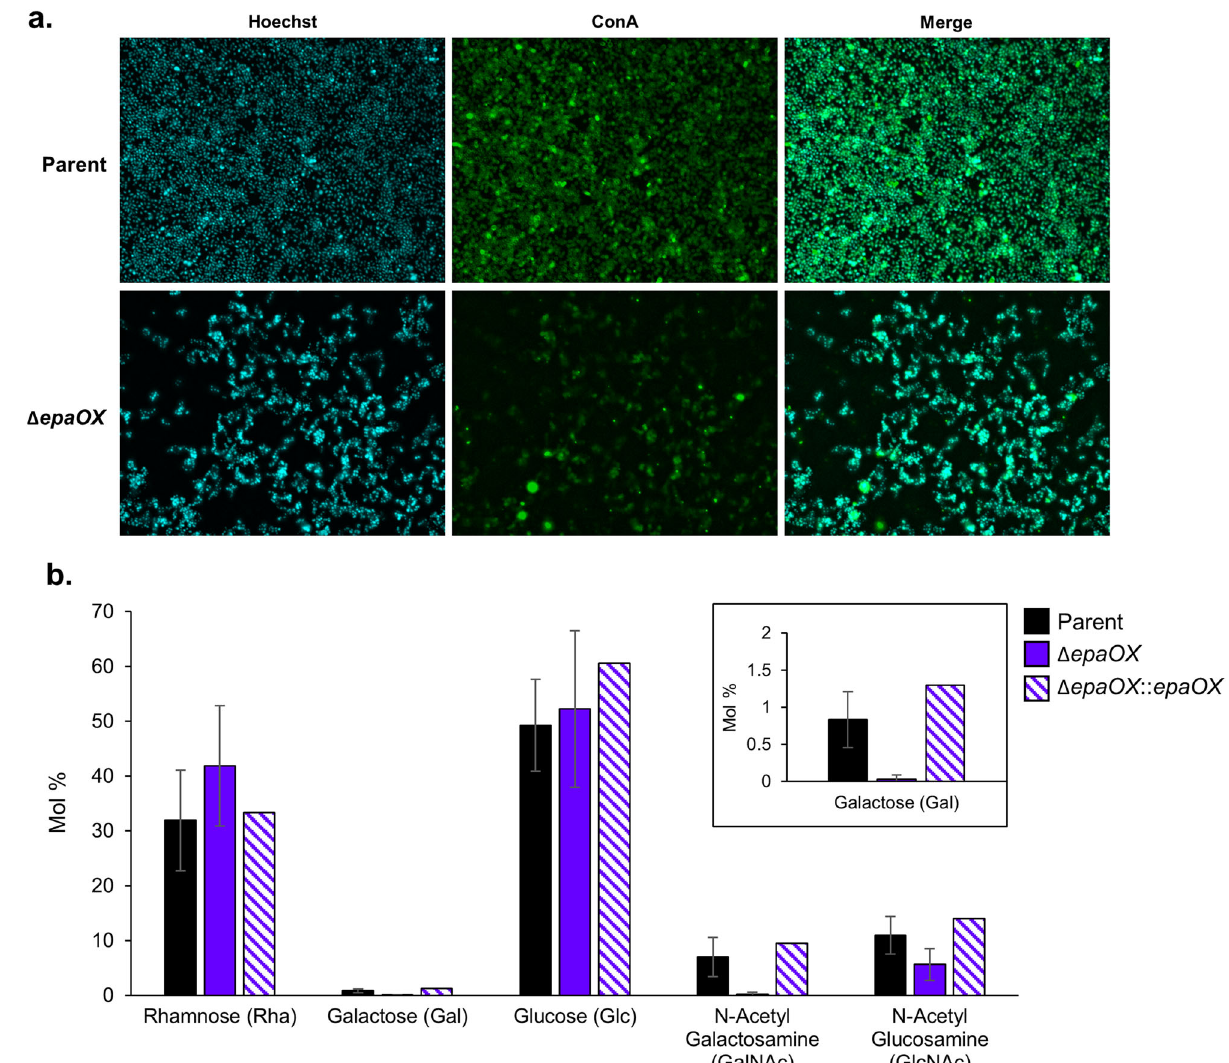
Fig. 6 Deletion of epaOX affects lectin-binding ability and polysaccharide composition. a Immuno fl uorescence micrographs of parent and Δ epaOX bio fi lms. E. faecalis cells were cultured on Aclar membranes in CBRs for 24 h and stained with the DNA label Hoechst 33342 ( blue ) and the fl uorescein-labeled lectin concanavalin A (ConA — green ). Representative images at a magni fi cation of 100× are shown from experiments performed in triplicate. b Carbohydrate composition of puri fi ed polysaccharides obtained from parent, Δ epaOX , and Δ epaOX::epaOX strains. E. faecalis strains were cultured to exponential phase for polysaccharide extraction. Error bars represent standard deviation ( n = 3 for parent, Δ epaOX ; n = 1 for Δ epaOX::epaOX